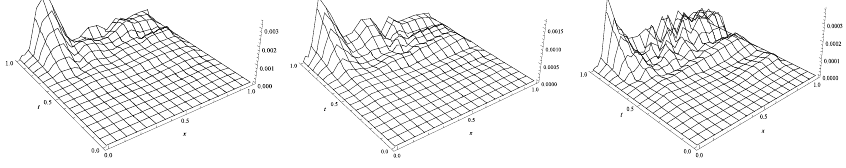
Figure 4. Max error with ε = 10 − 6 (Left: N = 200; Middle: N = 400; Right: N = 800) for Example